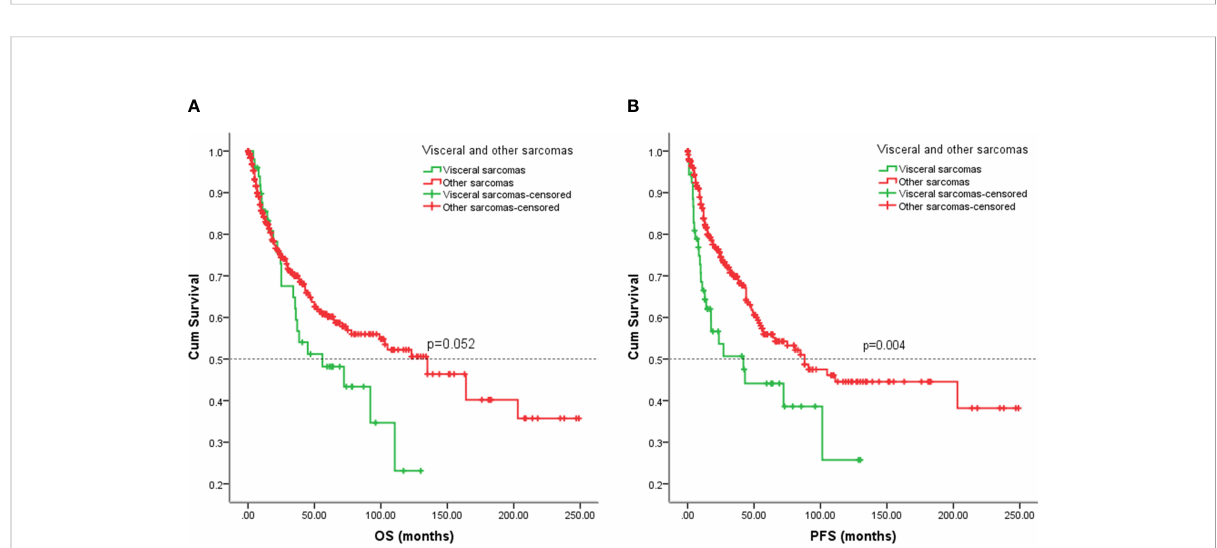
FIGURE 7 Kaplan-Meier analysis of OS and EFS for patients with visceral and other sarcomas. (A) Kaplan-Meier analysis of OS for patients with visceral and other sarcomas (p=0.052). (B) Kaplan-Meier analysis of EFS for patients with visceral and other sarcomas